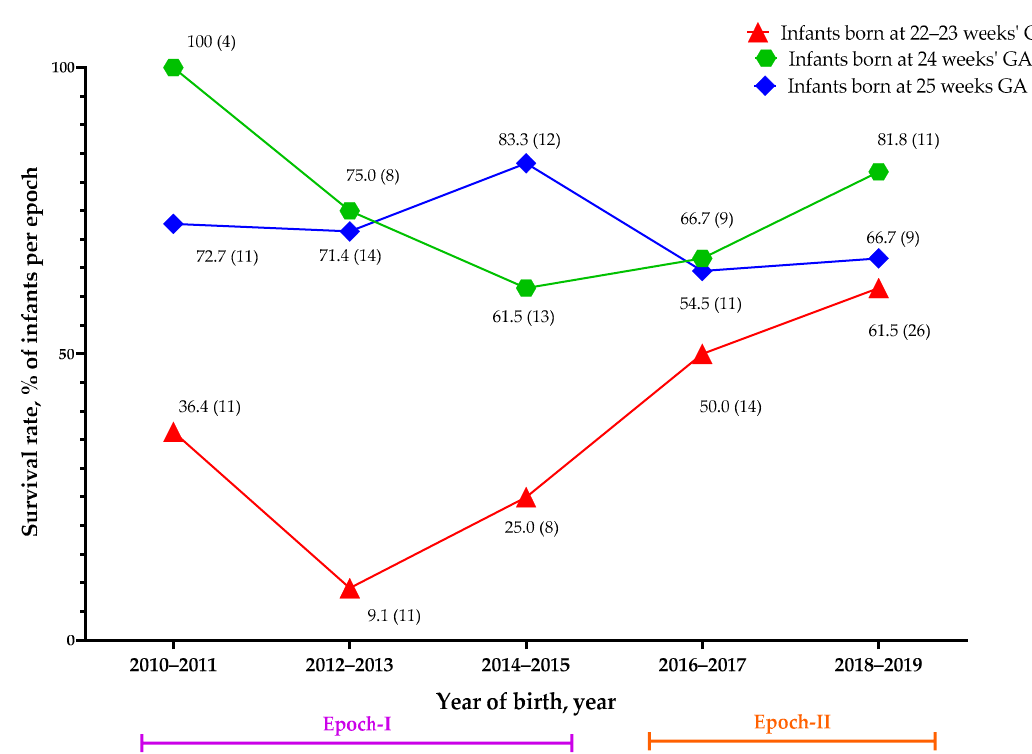
Figure 2. The biennial survival rate in each gestational age group. The data, along with the symbols, represent the survival rate as a percentage (total numbers in each population). GA: gestational age. Table 3. Dependence of survival at discharge on clinical variables: multivariate